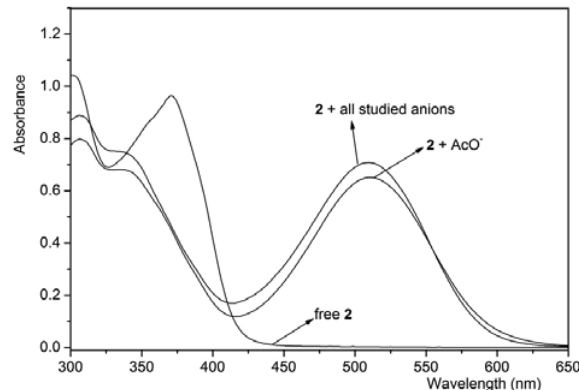
Fig. 6. UV-vis spectral changes of compound 2 (4.0 × 10 –5 mol · L –1 ) upon the addition of anions (8.0 × 10 –5 mol·L –1 ).